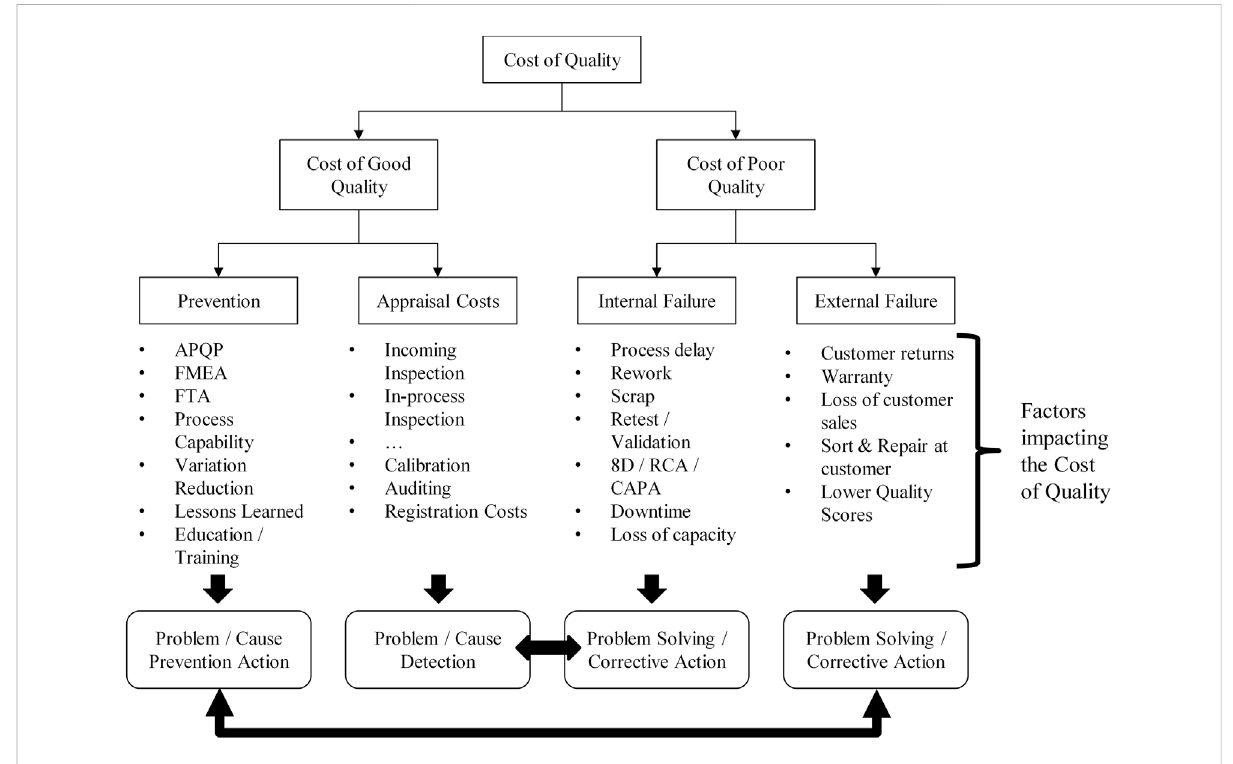
FIGURE 1 The cost of quality according to Juran [adapted from (Kiran,